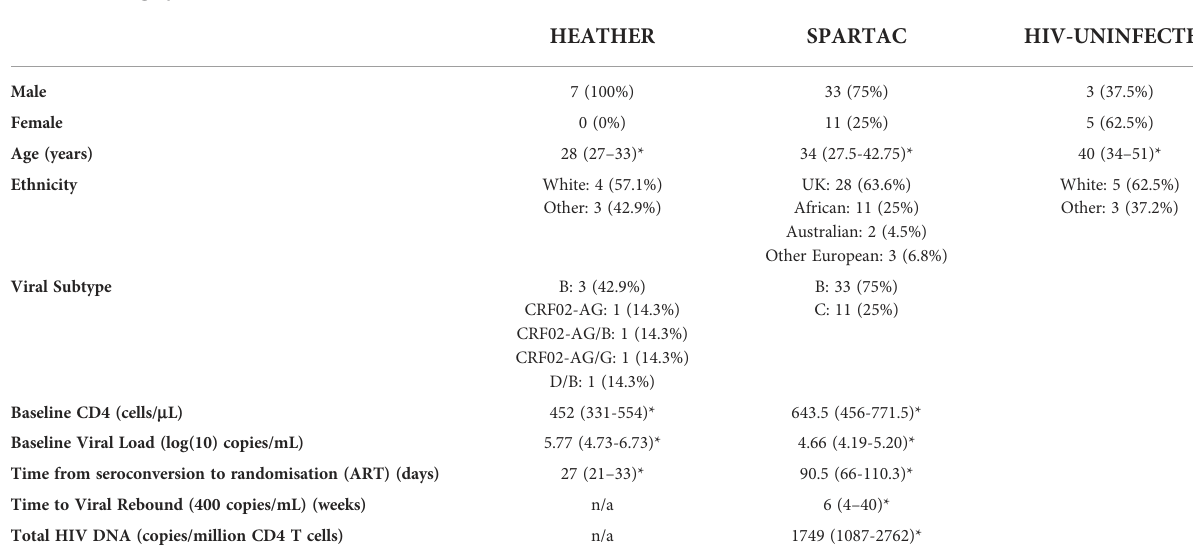
TABLE 1 Demographics of